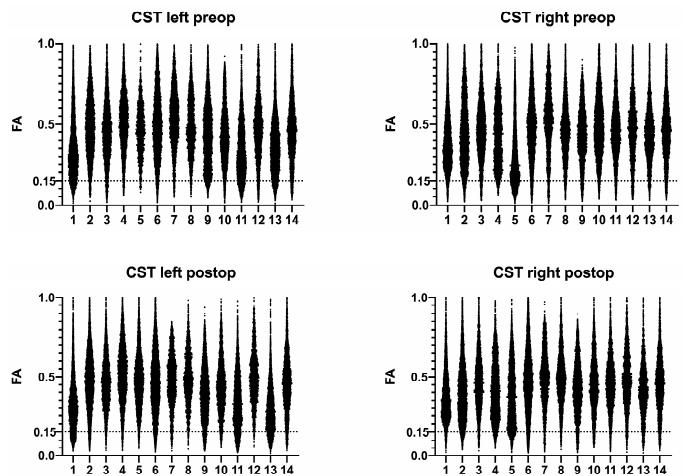
Figure 3. The individual distribution of the FA values in all patients before and after surgery. Dotted line: 0.15. The fifth percentile of every CST is given in Table 2. Note that especially infiltrated or compressed CSTs present an altered FA distribution toward the lower values. In infiltrated or compressed CSTs, the fifth percentile of FA values was 0.1407 ± 0.0109. In all other CSTs, the fifth percentile was 0.1763 ± 0.0040 ( p =